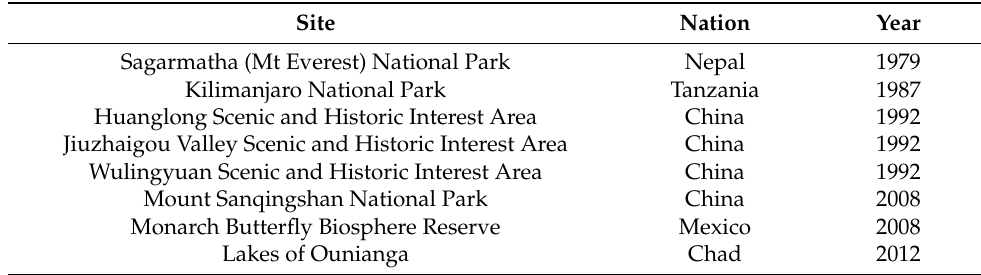
Table 3. Sites listed only under Criterion